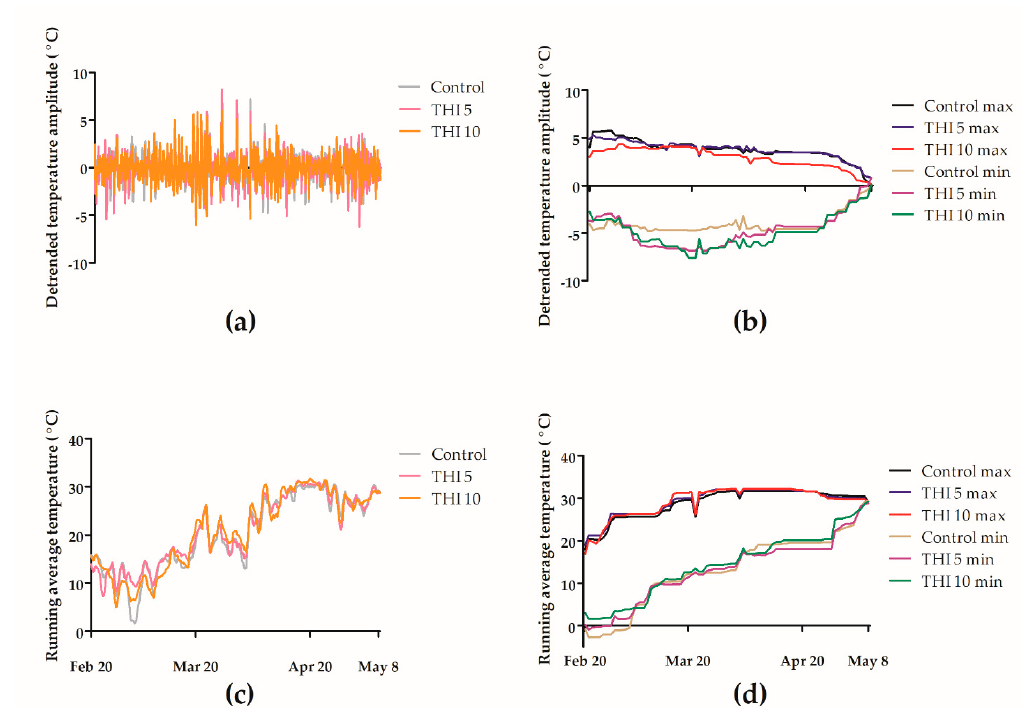
Figure 7. Environmental doses of (5 and 10 ng/g) thiamethoxam do not significantly affect within hive temperature during winter and early spring compared to controls. Honey bee colonies were exposed to thiamethoxam (THI) during winter 2018–2019 in field trial 2. Lines indicate mean detrended temperature amplitude ( a ), maximum and minimum detrended temperature amplitude ( b ), mean running average temperature ( c ), and maximum and minimum running average temperature ( d ), in degrees Celsius, for 10–14 colonies for 78 days, from February to May 2019.